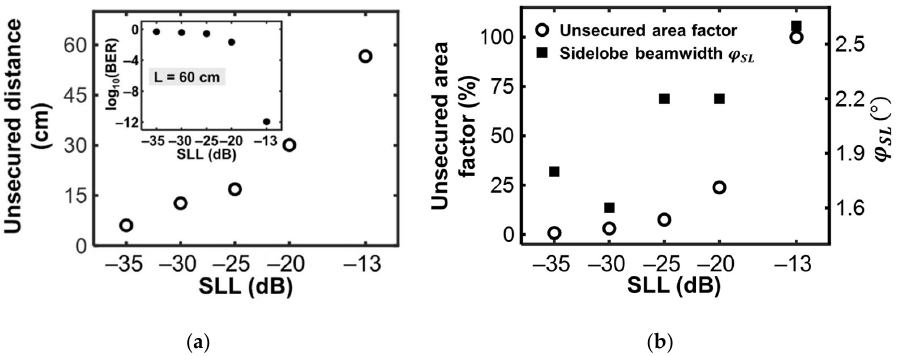
Figure 7. ( a ) Unsecured distance as a function of the sidelobe level (SLL) and inset: BER as a function of SLL for a transmission length of 60 cm; ( b ) Unsecured area factor (circle) and sidelobe beamwidth (square dots) as a function of the SLL.